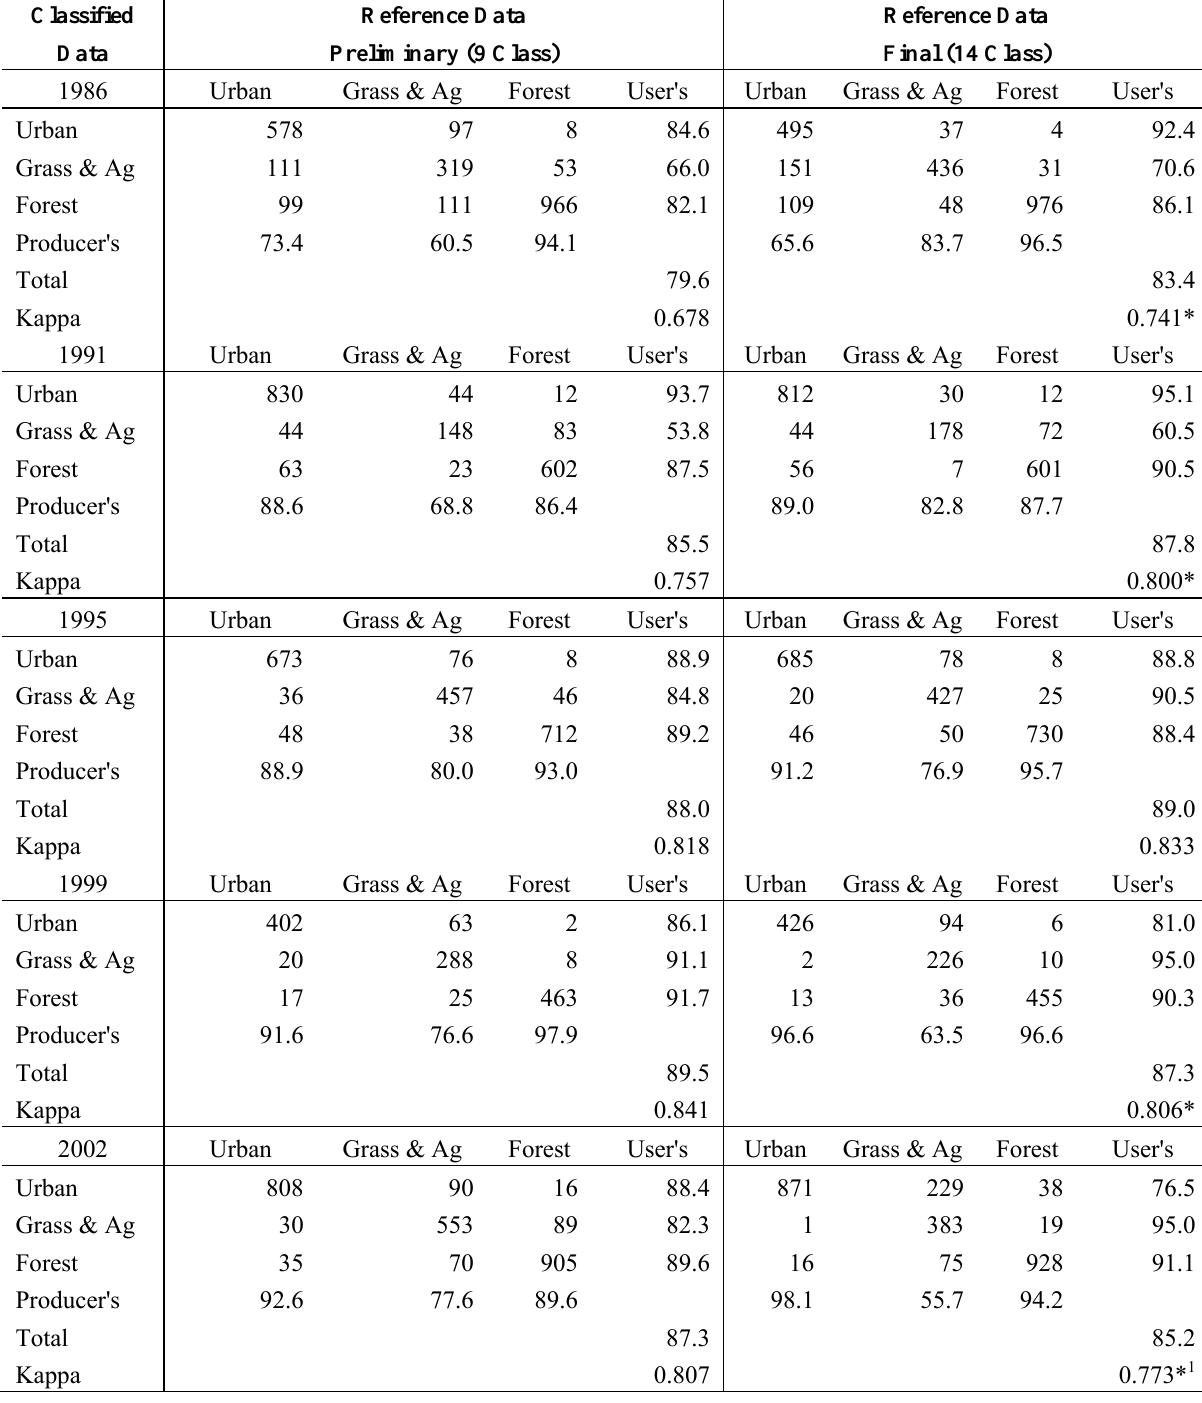
Table 6. Class accuracy assessment (user’s and producer’s, total and Kappa-adjusted accuracy, and significance difference between two classifications at alpha 0.05) for three land cover class groupings for the preliminary and final land cover maps. For individual class accuracies see Appendix